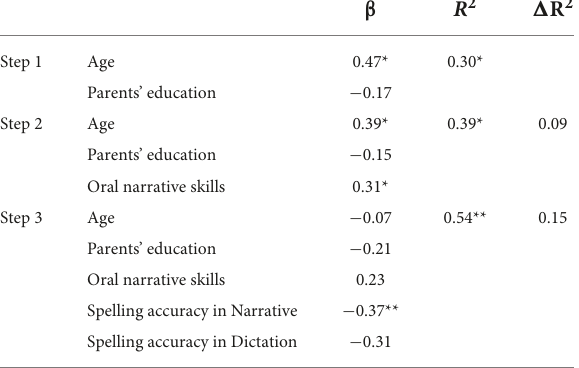
TABLE 5 Stepwise regression for BLM children (dependent variable: written narrative skills).